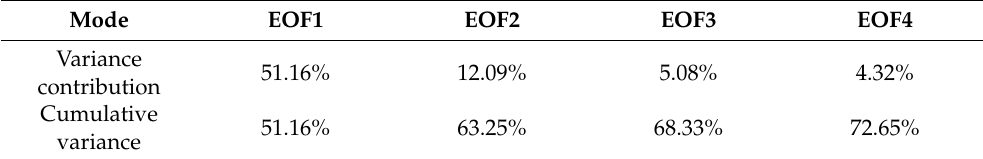
Table 1. The variance contribution and cumulative variance (unit: %) of the first 4 modes. Mode EOF1 Variance